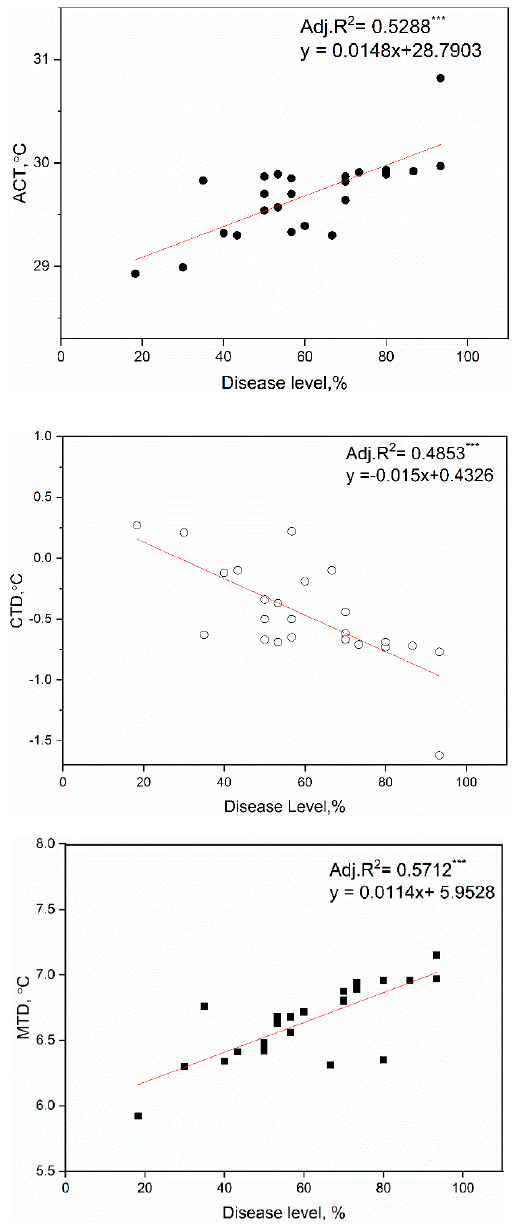
Figure 3. Regression analyses between Average Canopy Temperature (ACT), Canopy Temperature Depression (CTD), and Maximum Temperature Depression (MTD) and disease level at the end of the experiment (DAI 38) for 25 wheat varieties.